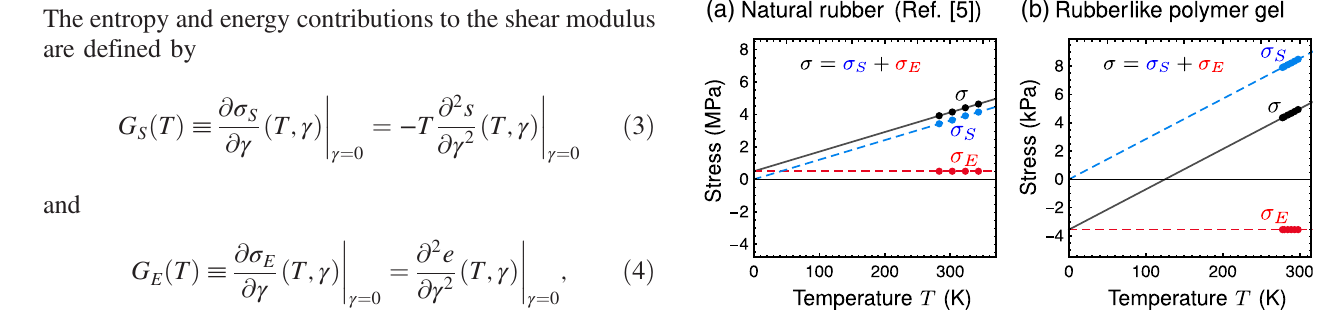
FIG. 1. Irrelevant energy elasticity in natural rubber and relevant negative energy elasticity in a rubberlike polymer gel. (a) Temperature ( T ) dependence of the tensile stress σ (black symbols) of vulcanized rubber through stretching measurements under 60% strain. The data are taken from Ref. [5]. The gray solid line is obtained from a least-squares fit and extrapolated to T ¼ 0 K. According to Eq. (1), we have the entropy contribution σ (blue dashed line) and the energy contribution σ S line), which corresponds to the intercept of the gray solid line. In the measured temperature range (black symbols), the ratio of σ to σ is less than 15%. Similarly, small energy contributions to E elasticity are observed in many rubber materials [6 – 10]. (b) Typ- ical result of the T dependence of the shear stress σ (black symbols) of a polymer gel through rheological measurements under 60% shear strain γ . The gel sample is synthesized by equal- weight mixing of the two kinds of precursors whose molar mass M and concentration c are 20 kg = mol and 60 g = L, respectively. The gray solid, blue dashed, and red dashed lines are obtained in the same way as in (a). Notably, we find that σ negative